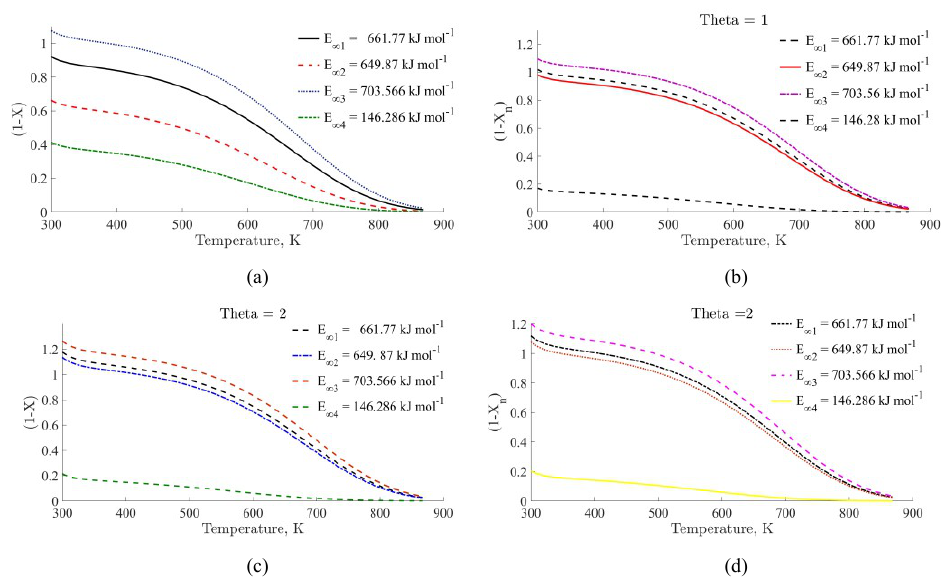
Fig. 1. The effect of upper limit ′𝐸 ∞ ′ (kJ mol −1 ) of dE integral on the numerical solutions of bi-variant scheme for distributed activation energy model (DAEM): (a) first order reaction ( θ = 1); (b) n th order reaction ( θ = 1); (c) first order reaction ( θ = 2); (d) n th order reaction ( θ = 2) ( A = 1.5·10 −005 s −1 , η = 10 − 9 kJ/mol, β = 0.0920, m = 10 °C min − 1 and n =